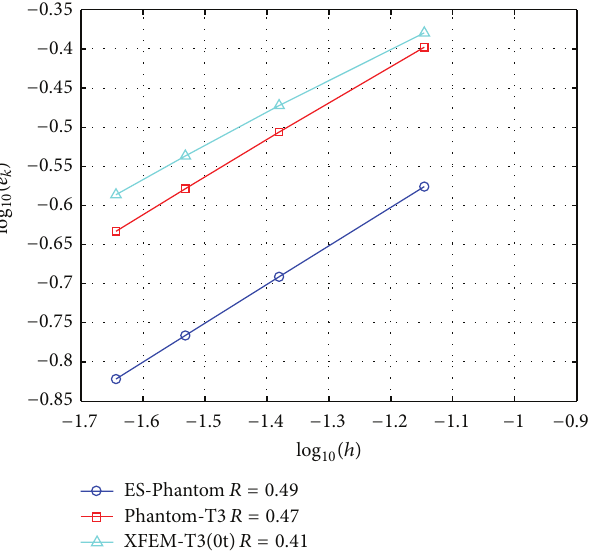
Figure14:Computationalefficiencyofenergynormfortheproblem of a sheet with an edge crack under remote tension.